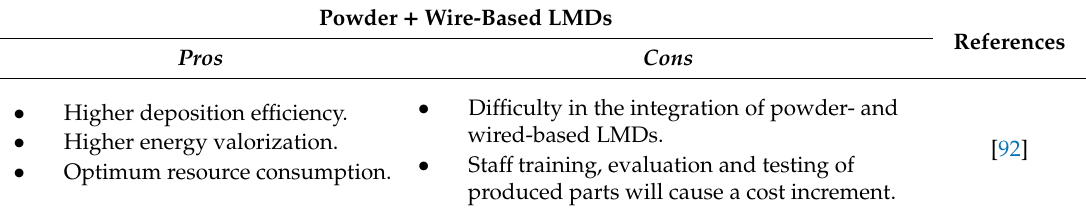
Table 5. Integration of powder- and wire-based